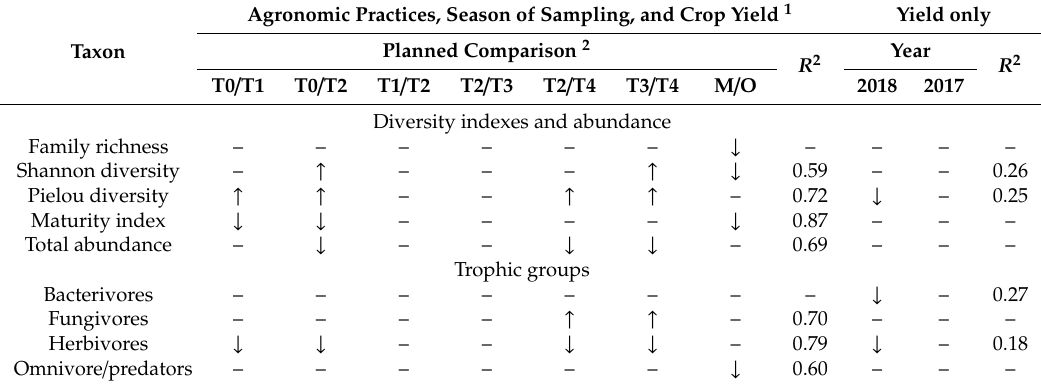
Table 6. Response of nematode community synecological parameters to agronomic practices, season, and crop yield (from two multivariate